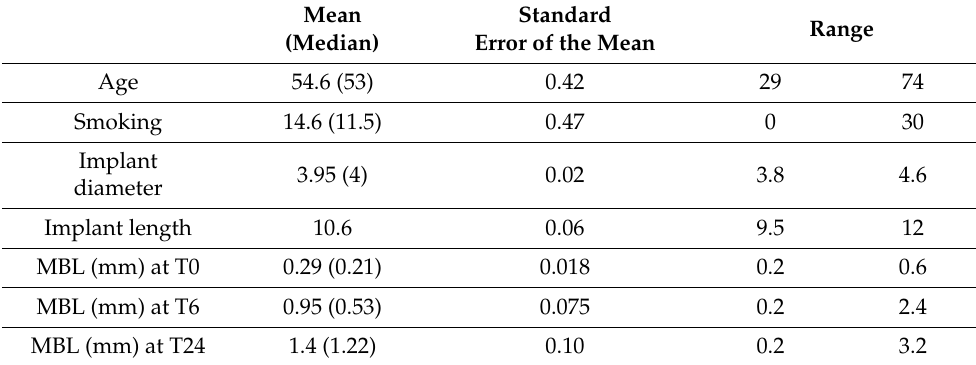
Table 2. Descriptive statistics for metric variables.